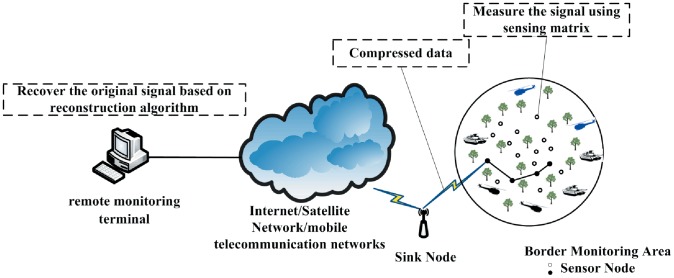
Network architecture diagram of the border monitoring WSN system.